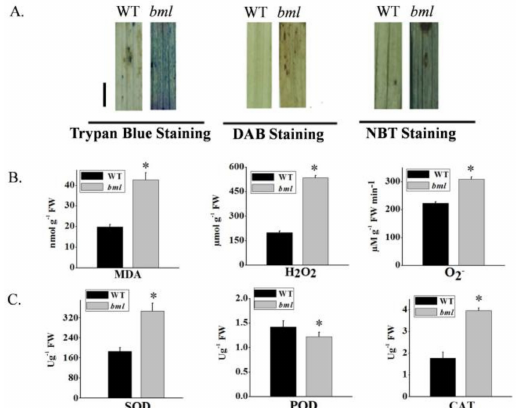
Figure 7. Histological staining and measurement of the activities of enzymes involved in scavenging and generating reactive oxygen species. ( A ) Analysis of histologically stained bml and WT rice leaves at the onset of heading, bar = 1 cm ( B ) Contents of malondialdehyde (MDA), hydrogen peroxide (H 2 O 2 ), and superoxide anions (O 2 − ). ( C ) Contents of the enzymes superoxide dismutase (SOD), ascorbate peroxidase (POD), and catalase (CAT) in bml and WT at the onset of heading. All data are shown asmeans ± SD of five replicates; * p < 0.05 by Tukey’s method. DAB: diaminobenzidine; NBT: nitro blue